Question: Give a one-sentence summary of this figure.
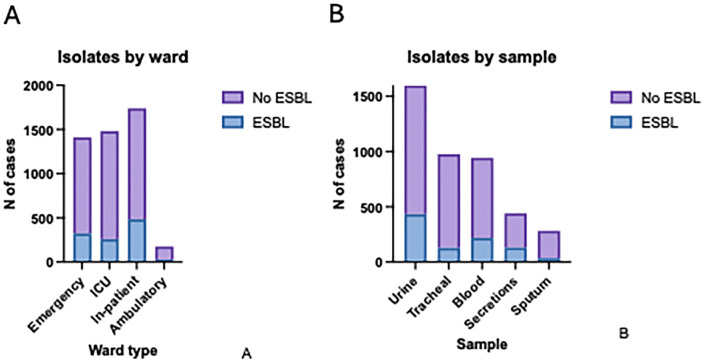
Answer: Distribution of Klebsiella pneumoniae isolates by ward and clinical specimen. (A) Distribution of Klebsiella pneumoniae isolates according to hospital ward. (B) Distribution according to clinical specimen. Bars show the total number of isolates and the proportion of presumptive ESBL-producing isolates in each category. ESBL = extended-spectrum beta-lactamase. Source: Original from the authors.